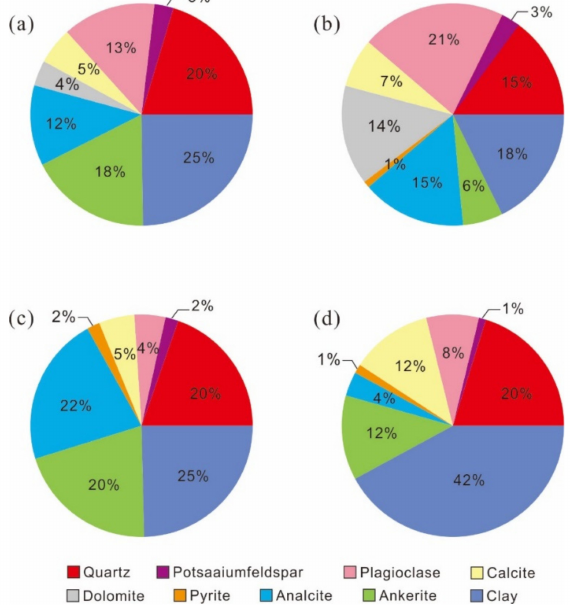
Figure 4. Mineralogy of the second Member of Kongdian Formation in Cangdong Sag. ( a ) Com- bination of FQL and CLL; ( b ) combination of FQL, CLL, and BCL; ( c ) combination of FQL, CLL, and OML; ( d ) combination of FQL, CAL, CLL, and OML. FQL: feldspar-quartz laminae; CLL: clay laminae; CAL: carbonate laminae; OML: organic matter laminae; BCL: bioclastic